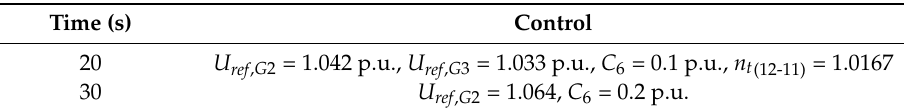
Figure 9. Adaptive horizons applied in case A. Table 2. Control actions in case A.